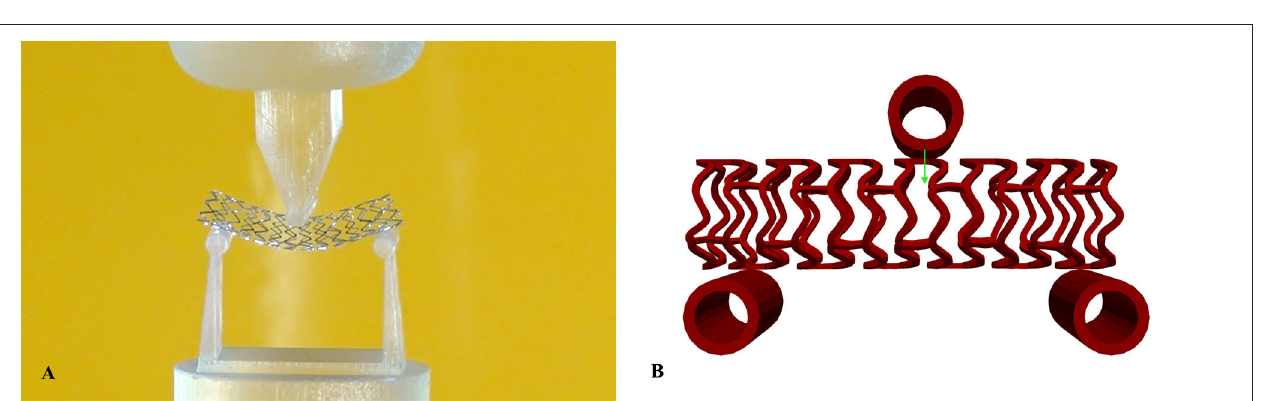
Frontiers in Medical Technology |